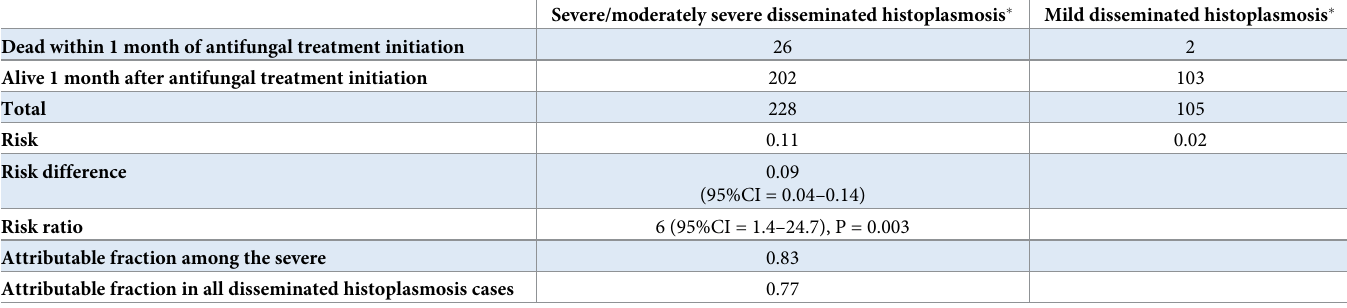
Table 2. Risk of death at 1 month for severe/moderately severe or mild progressive disseminated histoplasmosis according to the PAHO definition and for actually given first line treatment. Severe/moderately severe disseminated histoplasmosis � Mild disseminated histoplasmosis